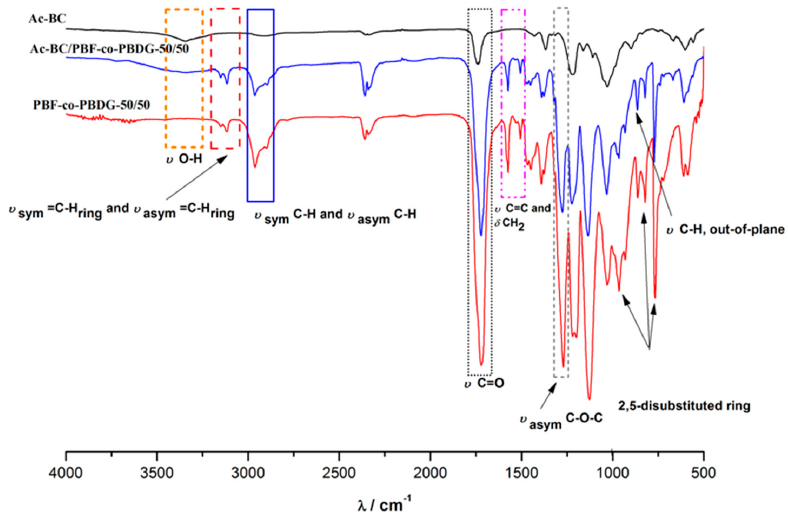
Figure 1. Attenuated total reflectance Fourier transform infrared (ATR FTIR) spectra of Ac-BC/PBF- co -PBDG-50/50 nanocomposite and corresponding Ac-BC and PFB- co -PBDG-50/50 components. The Ac-BC/PBF- co -PBDG nanocomposites displayed the typical vibration modes of furanoate- based polyesters [44] and in particular of PBF- co -PBDGs: two week bands centred at 3150 and 3115 cm − 1 arising from the symmetrical and asymmetrical C–H stretching of the furanic ring ( ν sym = C–H ring and ν asym = C–H ring ), two other weak bands near 2962 and 2890 cm − 1 arising from the symmetrical and